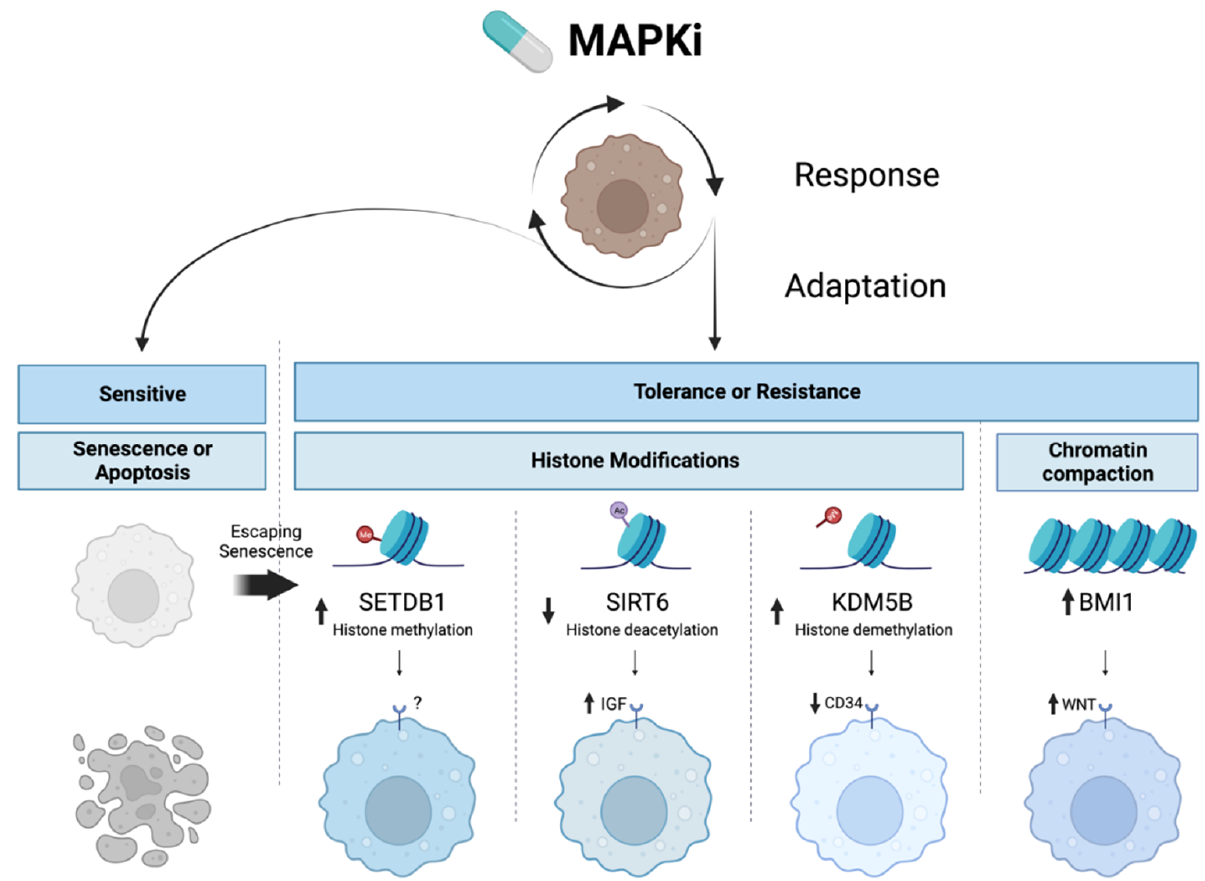
Figure 2. Epigenetic mechanisms underlying MAPKi resistance in melanoma. Inhibition of the MAPK pathway (MAPKi) results in the senescence or apoptosis of sensitive melanoma cell states. Meanwhile, escape from senescence and intrinsic and acquired resistance can be facilitated by histone modifications induced by SETDB1, SIRT6, and KMD5B or by chromatin compaction via BMI1, which activates cell survival pathways and changes melanoma cell states.